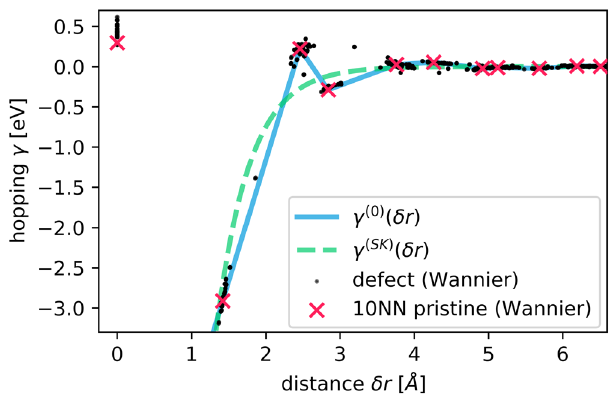
Fig. 4 Distance-hopping map of interaction elements. We plot all entries of a Wannier parametrization for the double vacancy defect in SLG (black dots) with both a Slater – Koster based initialization (taken from 40 ) γ (SK) ( δ r ) (dashed green line) as well as another initialization γ (0) ( δ r ) de fi ned as piece-wise linear interpolation (solid blue line) between the 10 th -NN distance-hopping values (red crosses) of a bulk singler layer graphene cell. The hoppings at distance zero represent the onsite energies s i .